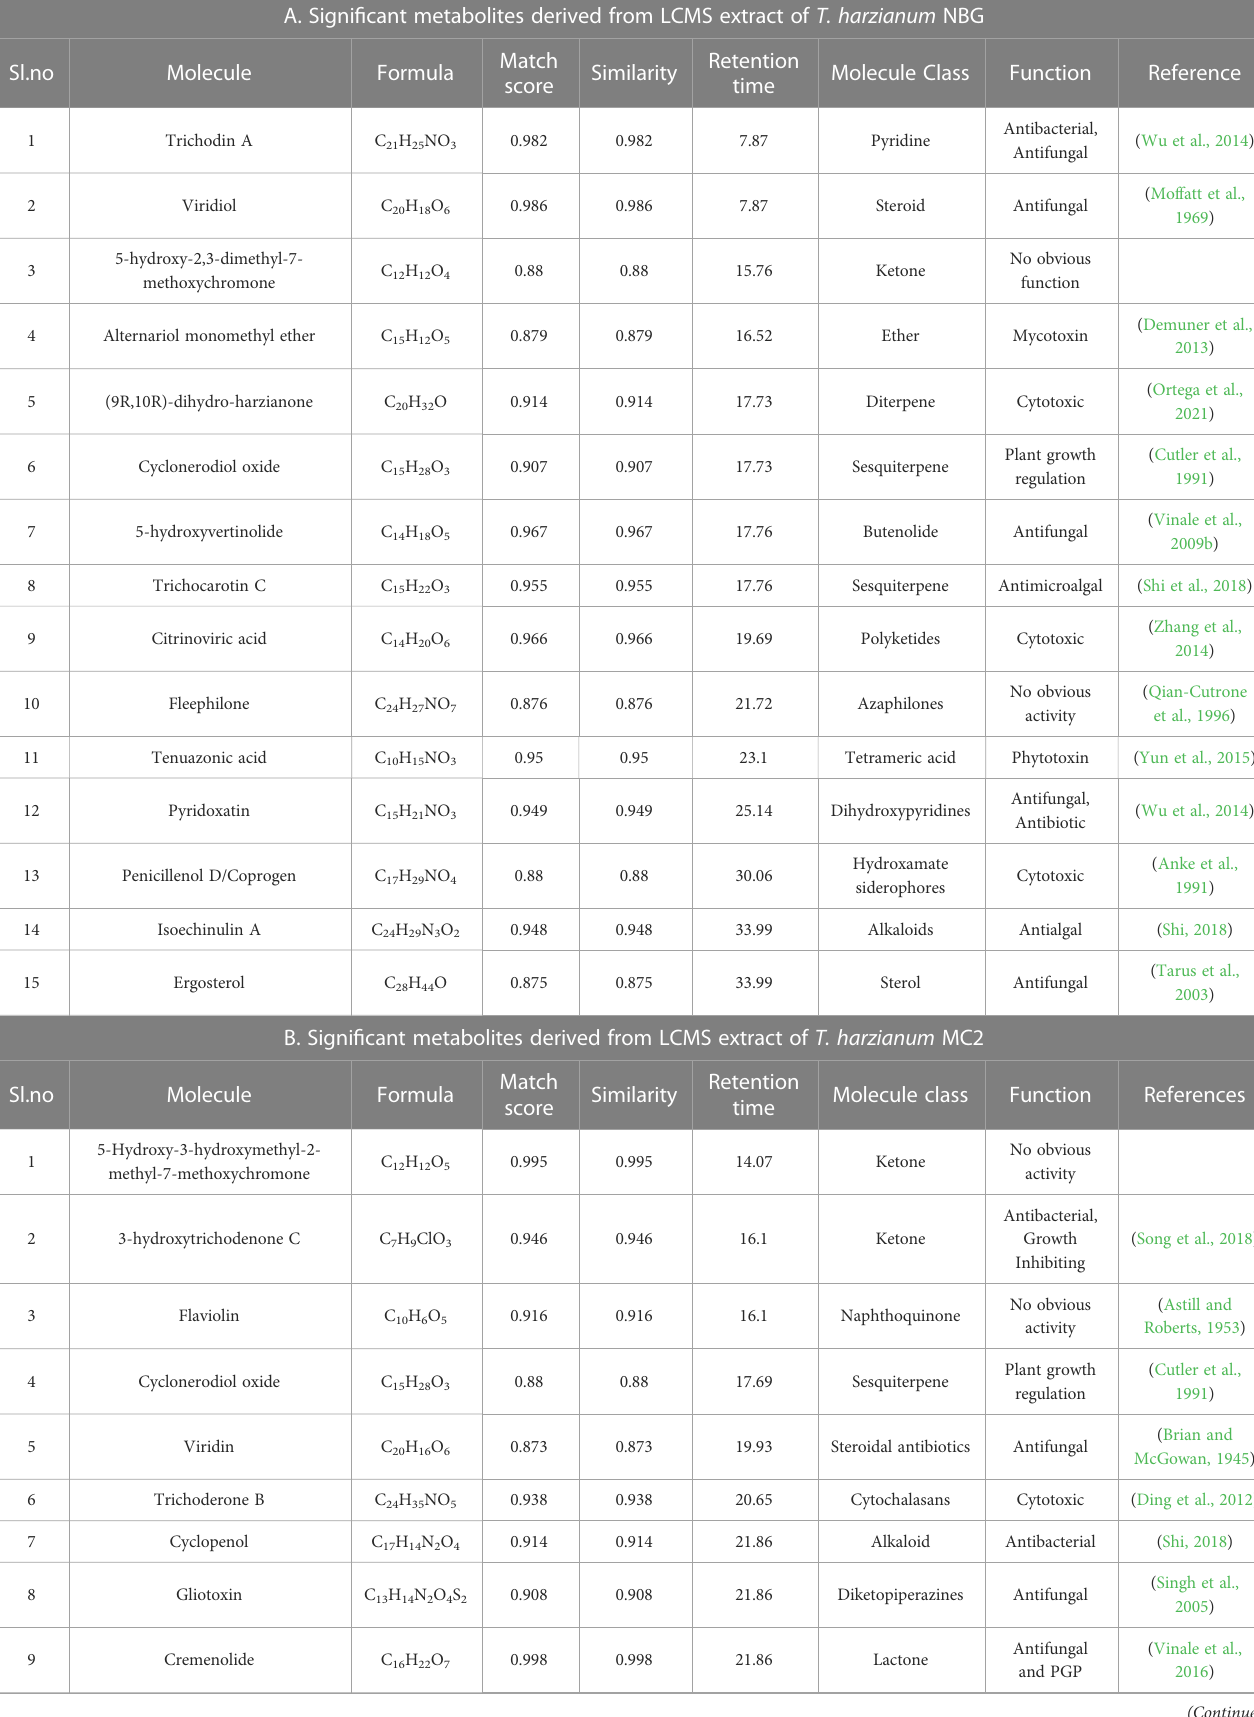
TABLE 7 List of antimicrobial compounds retrieved from LCMS analysis of T. harzianum MC2 and T. harzianum NBG. A. Signi fi cant metabolites derived from LCMS extract of T. harzianum NBG Sl.no Molecule Formula